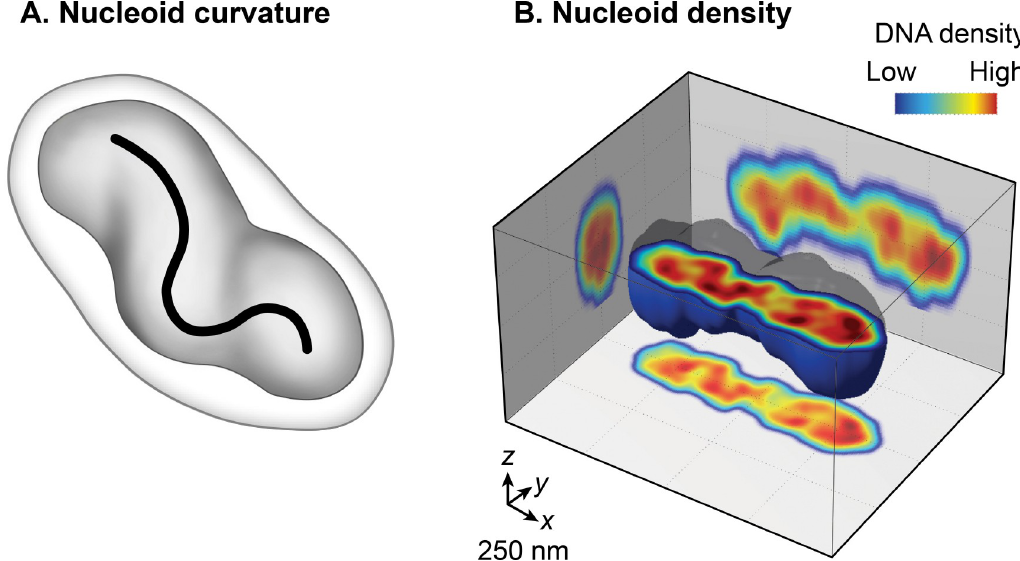
Fig 11. Nucleoid as a helical ellipsoid with longitudinal high-density DNA regions. A. A cartoon of E . coli cell with a curved nucleoid (dark grey). A curved centroids path, denoted by black line, emphasizes the curved shape of the nucleoid. The cartoon is based on a figure in [8]. B. Cross-sectioning of the E . coli nucleoid visualized by HU-mCherry. Fluorescence intensity is taken as a proxy for DNA density and is represented by blue to red in increasing order. Data were taken from